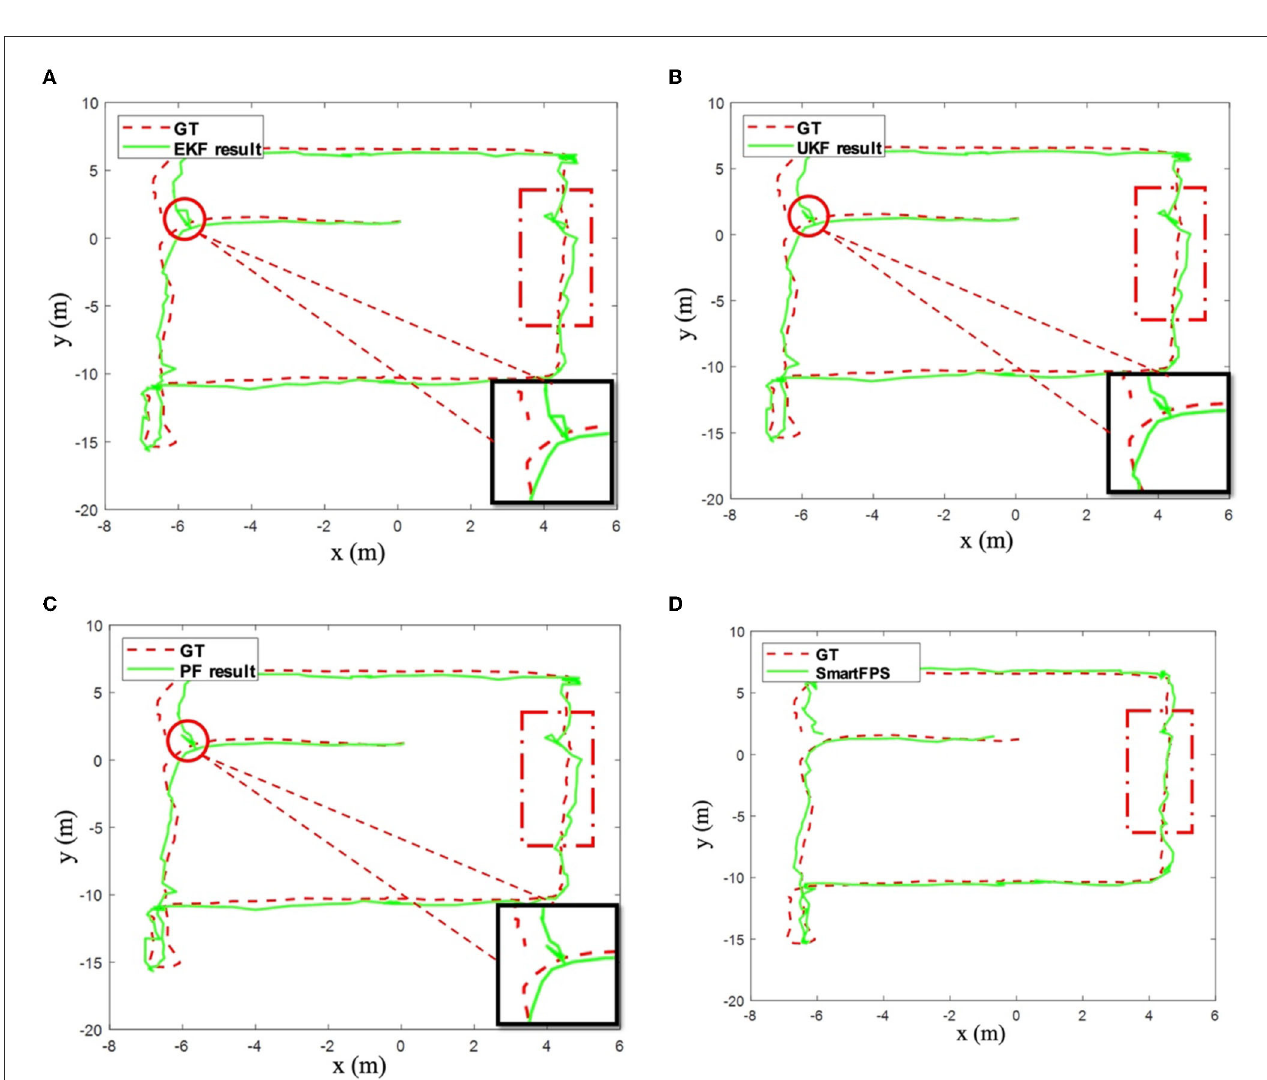
FIGURE8 (A) Testset 1 result by EKF. (B) Testset 1 result by UKF. (C) Testset 1 result by PF. (D) Testset 1 result by